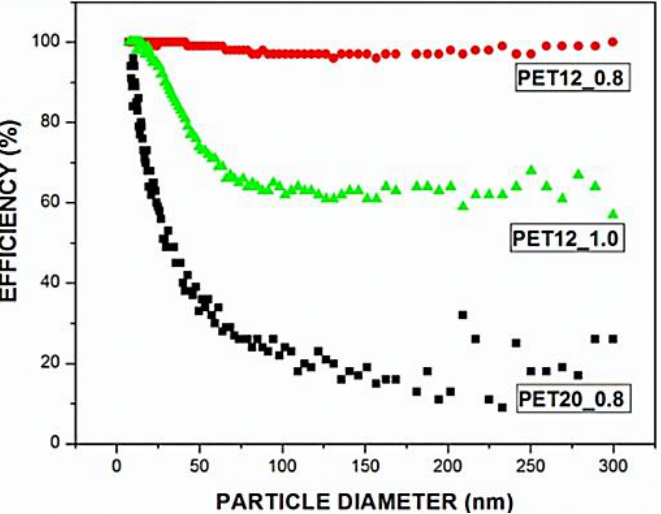
Figure 12. Fractional efficiency curves for samples with filtration velocity equal to 4.8 cm/s [208]. PET12_0.8 = particle diameter 100 nm; PET12_1.0 = particle diameter 70 nm; PET20_0.8 = particle diameter 20 nm. Reproduced with permission from MDPI.